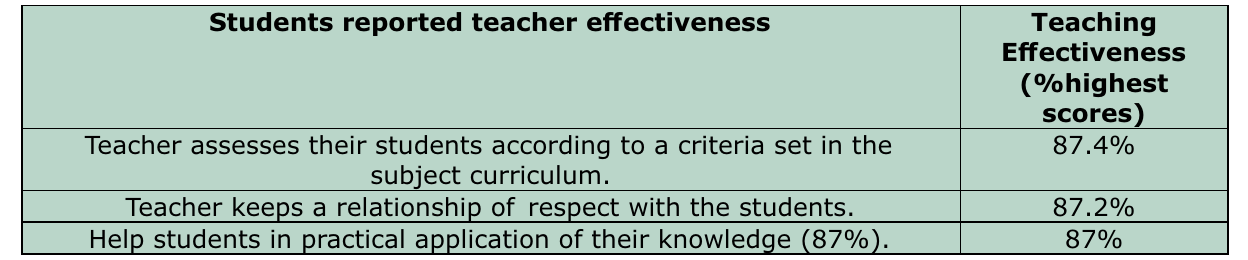
Table-IV: Descriptive statistics for students rated score of teaching effectiveness.